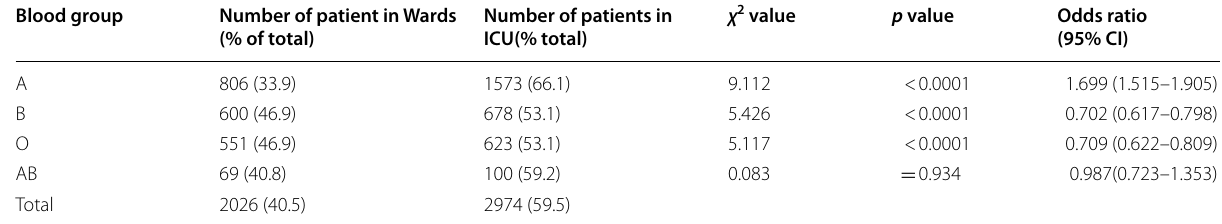
Table 3 Distribution of cases as per their admission status Blood group Number of patient in Wards (% of total)